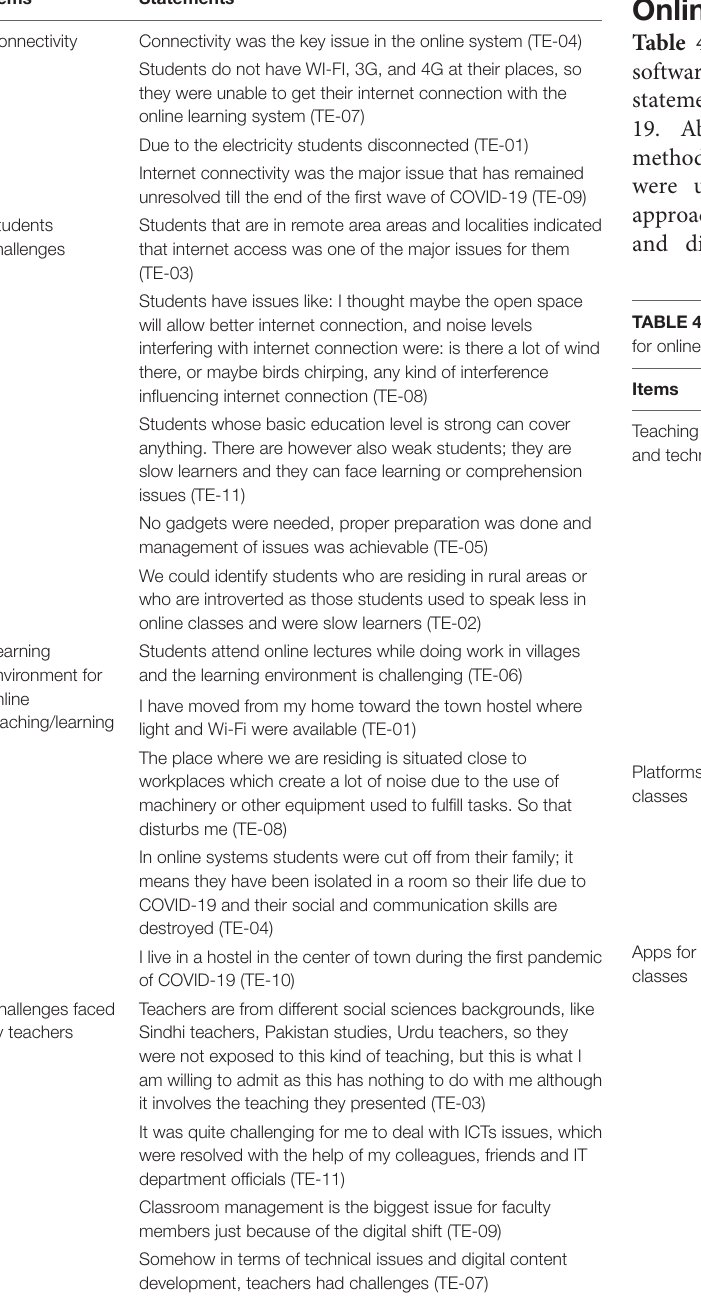
TABLE 3 | Challenges, issues, and problems of virtual classes during COVID-19.